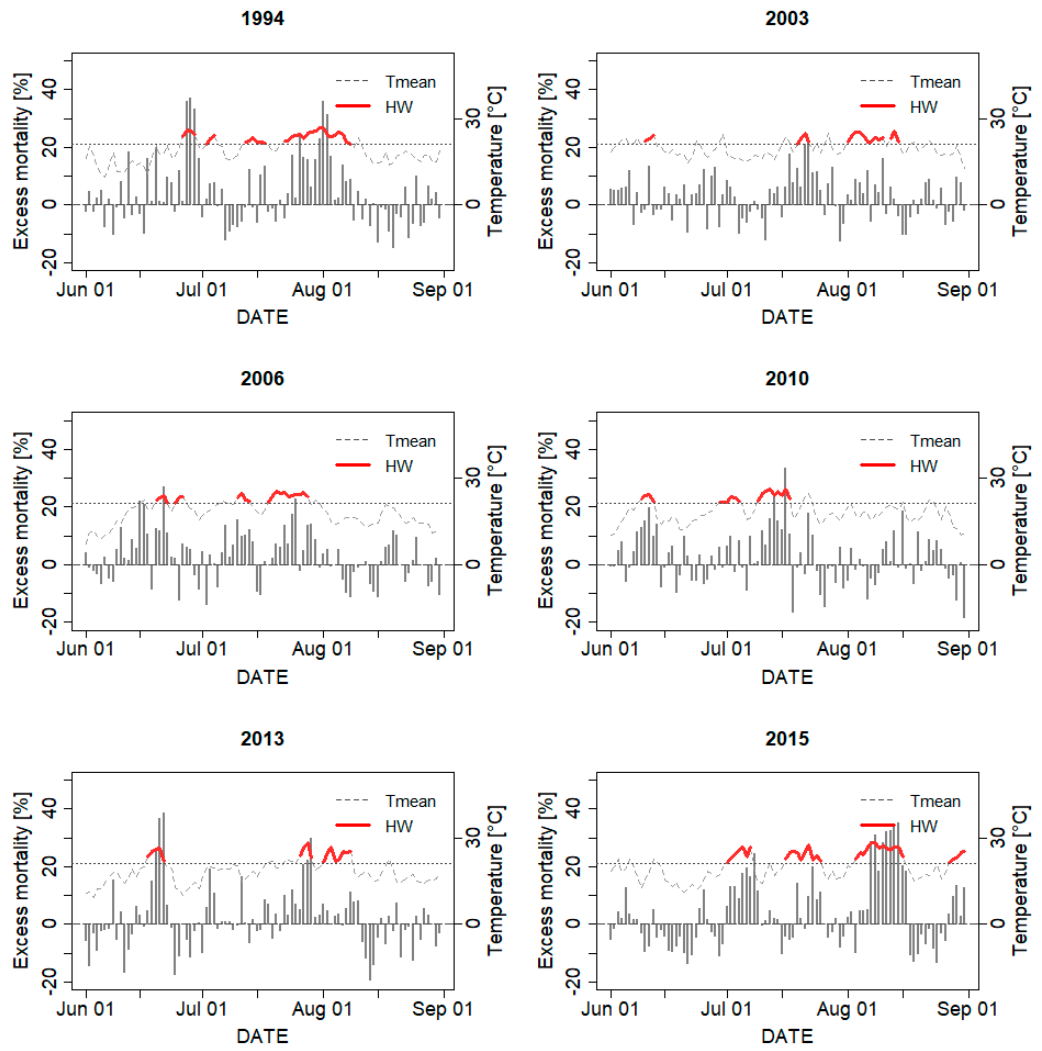
Figure 3. Relative excess mortality during summers (June–August) in six years with the total heat wave (HW) duration greater than 15 days. Tmean indicates daily mean temperature for the Czech Republic. A horizontal dotted line shows the heat wave threshold temperature—95th percentile of the annual daily mean temperature distribution during 1994–2015.